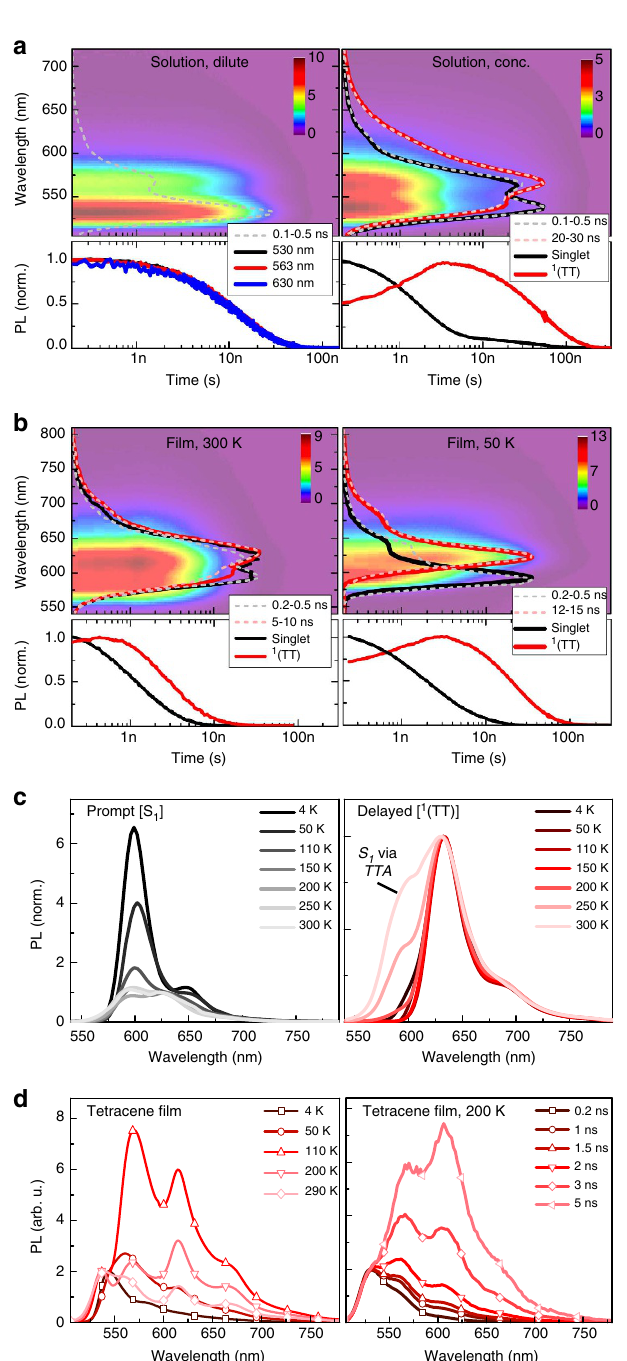
Figure 2 | 1 (TT) emission. F 2 -TES ADT time-resolved PL spectral maps for ( a ) solutions and ( b ) thin films. Prompt and delayed spectral components (solid lines) were extracted as described in the main text. Dashed lines are normalized spectral cuts from raw PL at the indicated time delays. Associated population kinetics (bottom) reveal sequential conversion from prompt to delayed emission. ( c ) Prompt and delayed F 2 - TES ADT film spectra extracted over the full temperature range, attributed to S 1 and 1 (TT), respectively. The delayed PL broadening at 4 200K reveals thermal repopulation of S 1 from 1 (TT) via TTA, process (iii) in Fig. 1b. ( d ) Normalized PL spectra of a tetracene film as a function of temperature in steady-state conditions (left) and time after excitation at 200K (right).